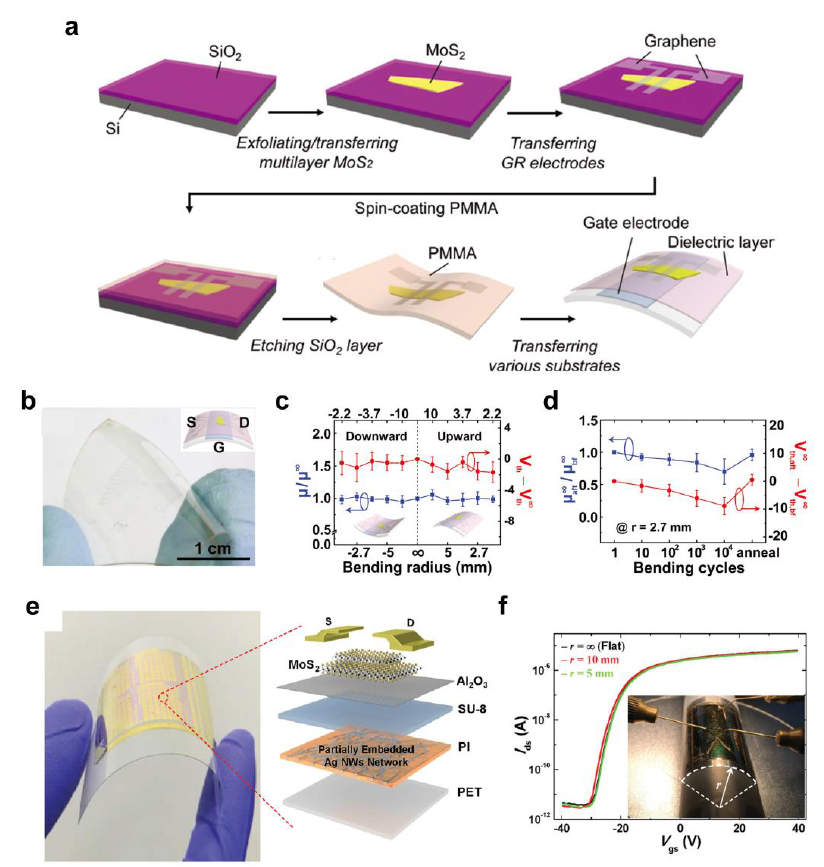
Figure 3. ( a ) Schematic diagram of the fabrication process and ( b ) photograph of the flexible and transparent 2D MoS 2 FET with graphene S/D electrode and ITO gate electrode on PET substrate. The change in μ and V T with respect to the ( c ) bending radius and ( d ) bending cycles [93]. Copyright © 2013, John Wiley and Sons. ( e ) Photograph (left) and schematic illustration of the device structures of the flexible 2D MoS 2 FETs with an Al 2 O 3 /SU − 8 bilayer dielectric and AgNW gate electrode. ( f ) Change in the transfer curves of the flexible 2D MoS 2 FETs in relation to the bending radius [21]. Copyright © 2016, John Wiley and Sons.